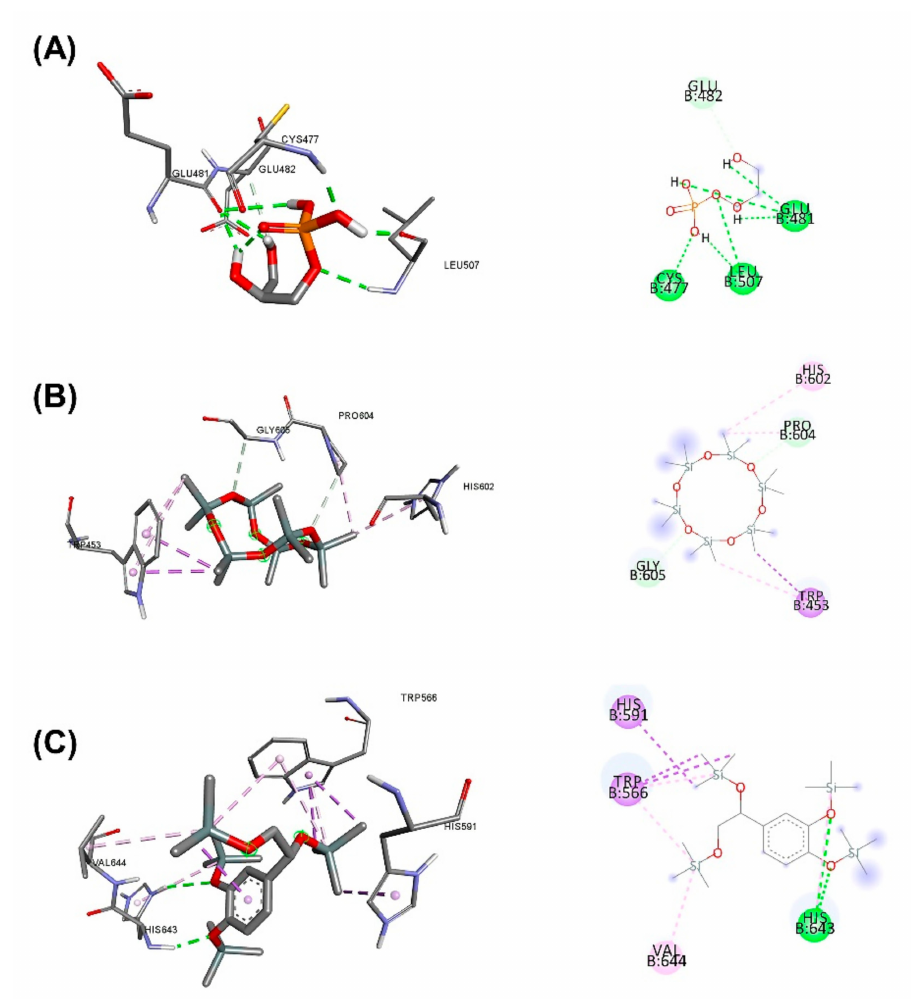
Figure 7. 3D (LHS) and 2D (RHS) Molecular docking pose visualization showing water extraction of C. tinctorius : ( A ) Alirocumab, ( B ) Cyclohexasiloxane, dodecamethyl-, ( C ) 3,4-Dihydroxyphenylglycol, 4TMS derivative interactions with